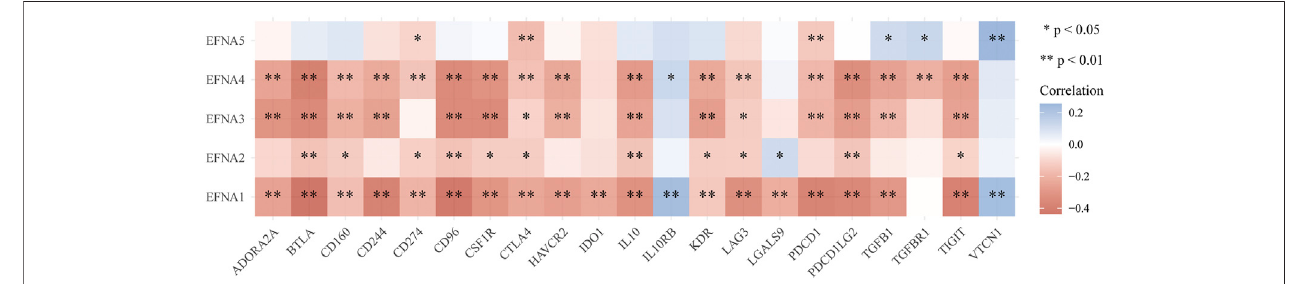
FIGURE 8 | Heat map of correlation analysis between EFNA family genes and immune checkpoints. The horizontal and vertical coordinates represent genes, in which different colors represent correlation coef fi cients (blue represents positive correlation and red represents negative correlation). The darker the color, the stronger the correlation between them; * p < 0.05, ** p <